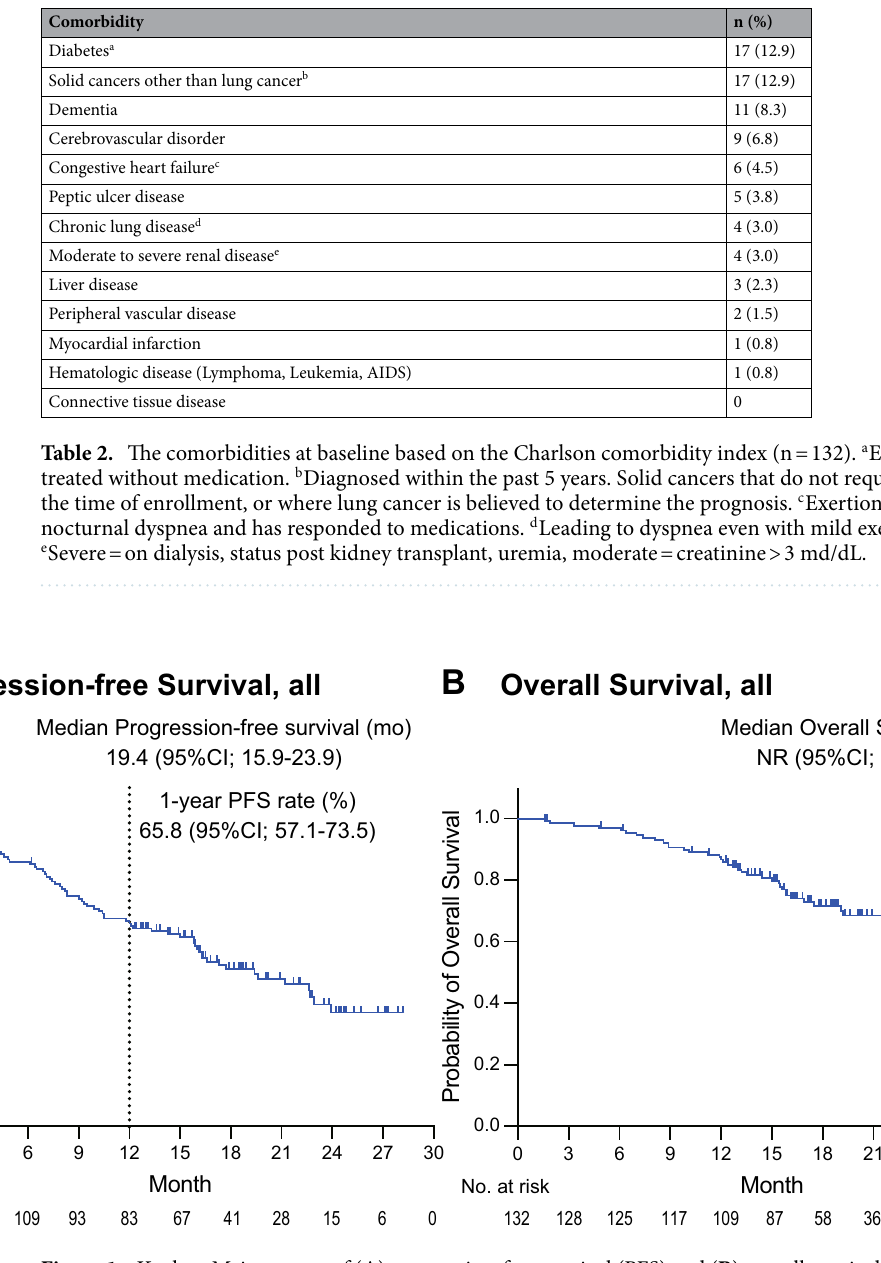
Figure 1. Kaplan–Meier curves of ( A ) progression-free survival (PFS) and ( B ) overall survival from osimertinib initiation in all patients. CI confidence interval, NR not